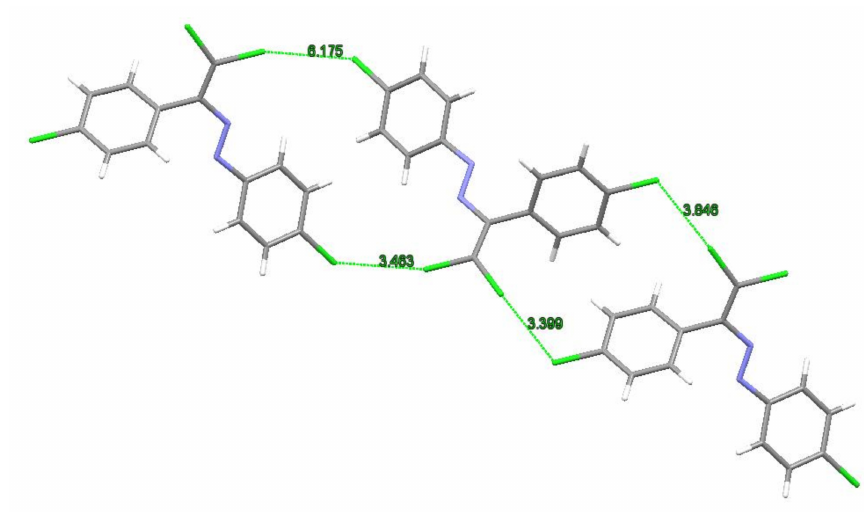
Figure 6. Multiple Cl ··· Cl contacts in halogenated aromatic dichlorodiazadiene.